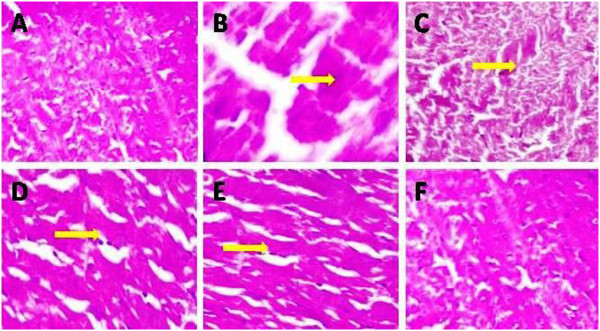
Paederia Foetida Linn. leaves extract effect on heart histopathology in normal and STZ induced diabetic rats. (A) Normal control: Did not display any changes (B) Diabetic control: Histopathology of diabetic control group rat display increased interstitial space and distort the intercalated disc (yellow arrow) (C)PF I (100 mg/kg): Histopathology of tested drug display decreased interstitial space and intercalated disc (yellow arrow) (D)PF II (250 mg/kg): Display only interstitial space (yellow arrow) (E)PF III (500 mg/kg): Display some intercalated disc (Yellow arrow) (F) Glibenclamide (10 mg/kg): Similar display live the normal control group histopathology. The samples were obtained from the same liver anatomical regions. For each group, 6 rats were examined and 50 pictures were taken. Original magnification, 40×.